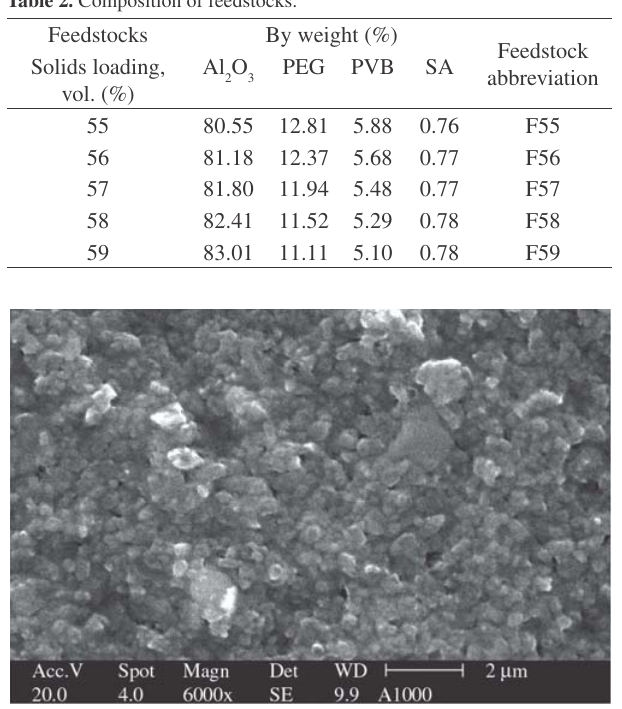
Figure 4. Feedstocks